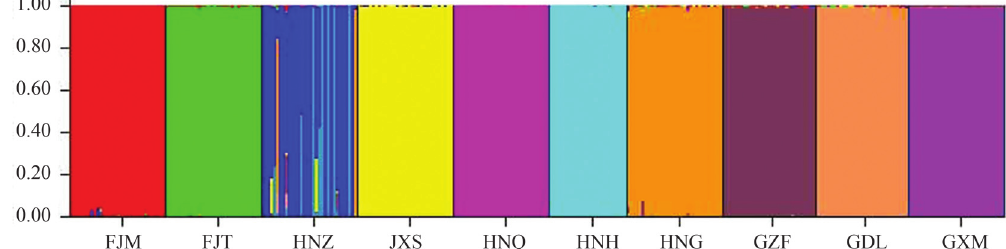
Figure 2 - Genetic structure of N . longibracteata populations as defined by STRUCTURE (K = 11) using prior information of population